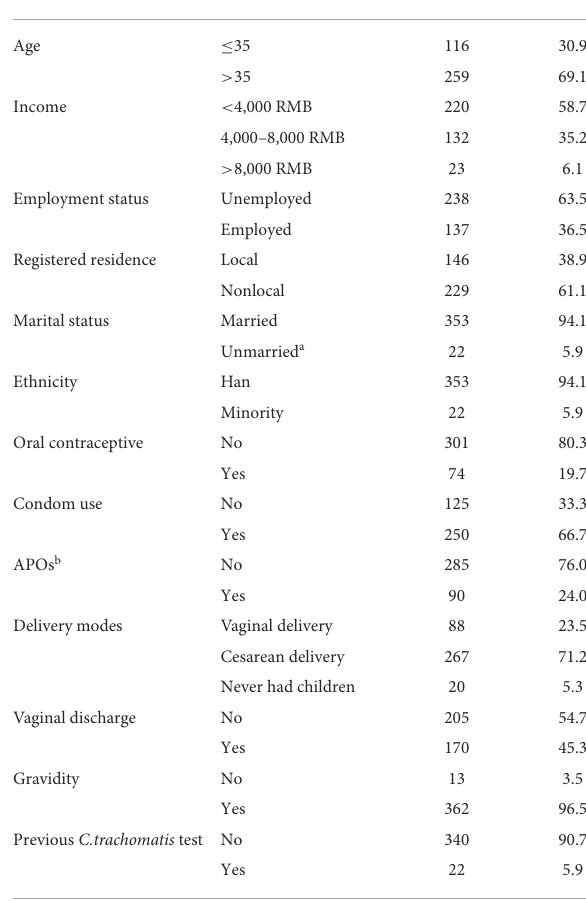
TABLE 1 Sociodemographic and clinical information in patients with C.trachomatis